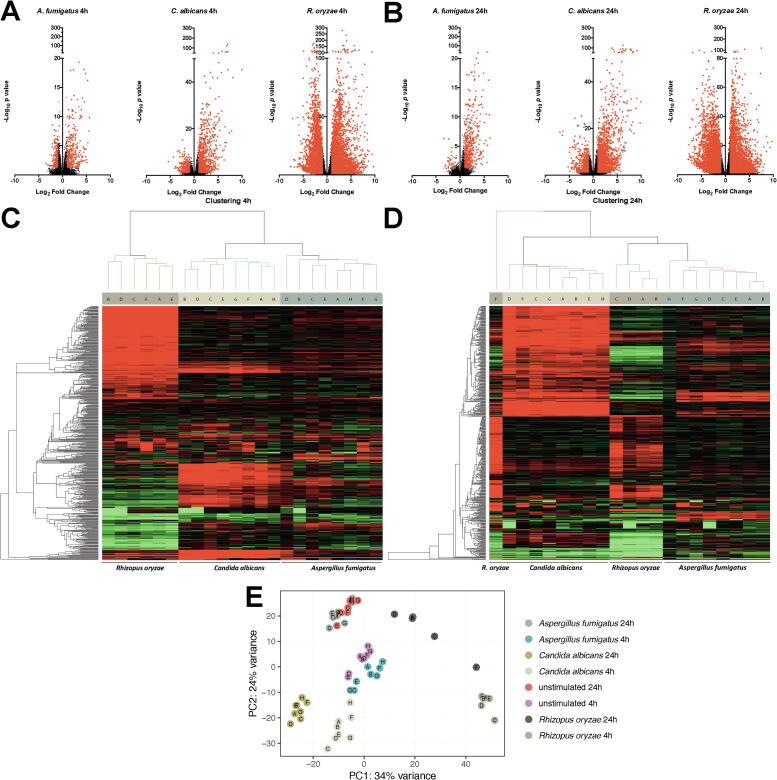
Transcriptional response to A. fumigatus, C. albicans, and R. oryzae (A-B) Volcano plots of differentially regulated genes assessed by RNA-Seq in human PBMCs from healthy volunteers in response stimulation with A. fumigatus (n = 8 donors), C. albicans (n = 8 donors), or R. oryzae (n = 6 and 5 donors for 4 and 24 h respectively) for 4 h (A) or 24 h (B). The plots represent Log2 fold change and -Log10 of the corrected p-value compared to the unstimulated control. Transcripts with a corrected p-value < 0.05 and a mean Log2FC > 1 of < −1 are plotted in red and were considered as differentially regulated. (D-E) Heatmap showing unsupervised clustering analysis of the transcriptional responses of PBMCs to the three fungal species. Distances were defined as 1 - Pearson correlation and average-linkage clustering was used. Numbers 1–8 on the branches of the dendrogram represent numbers of the respective PBMC donors after 4 h (C) and 24 h (D) of stimulation. After QC 2 donors stimulated for 4 h and three donors stimulated for 24 h with R. oryzae needed to be excluded. (E) Principal component analysis of the transcriptional response signatures. Data from each individual sample is plotted along the two main principal components (PC1, PC2). The two principal components account for 24–34% of the total variance in gene expression (PC1 34%; PC2 24%). Samples from the various stimulations are color coded as follows: C. albicans 4 h (light beige) and 24 h (golden), A. fumigatus 4 h (teal blue) and 24 h (blue grey), R. oryzae 4 h (dark beige) and 24 h (brown), and unstimulated 4 h (Purple) and 24 h (light red). (For interpretation of the references to color in this figure legend, the reader is referred to the web version of this article.)